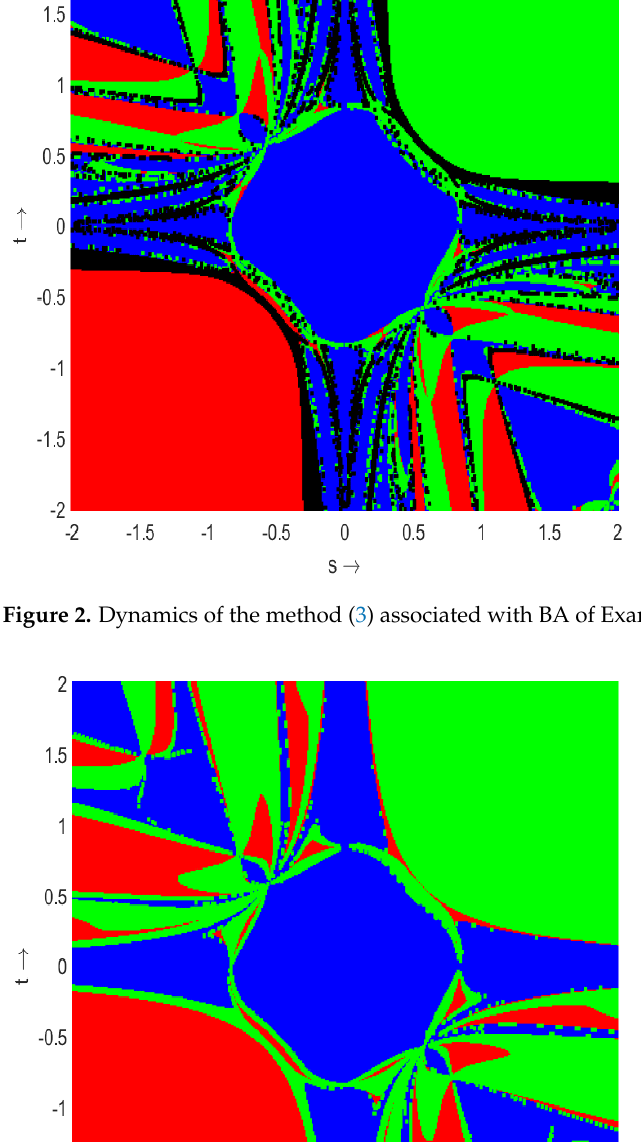
(cid:112) ( 3 ) /2 ) , the blue region is the set of all (cid:112) ( 3 ) /2 ) and the green region